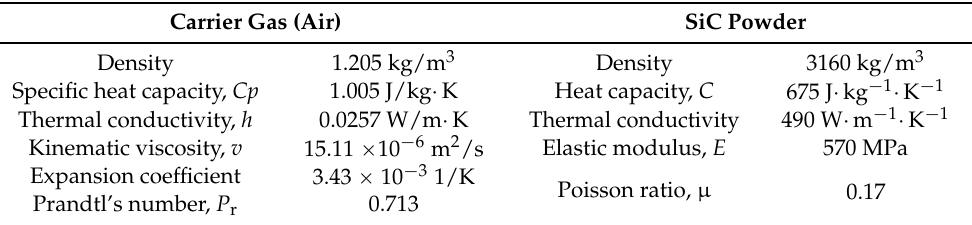
Table 1. Thermo mechanical properties of the carrier gas (air) and the silicon carbide (SiC) powder.